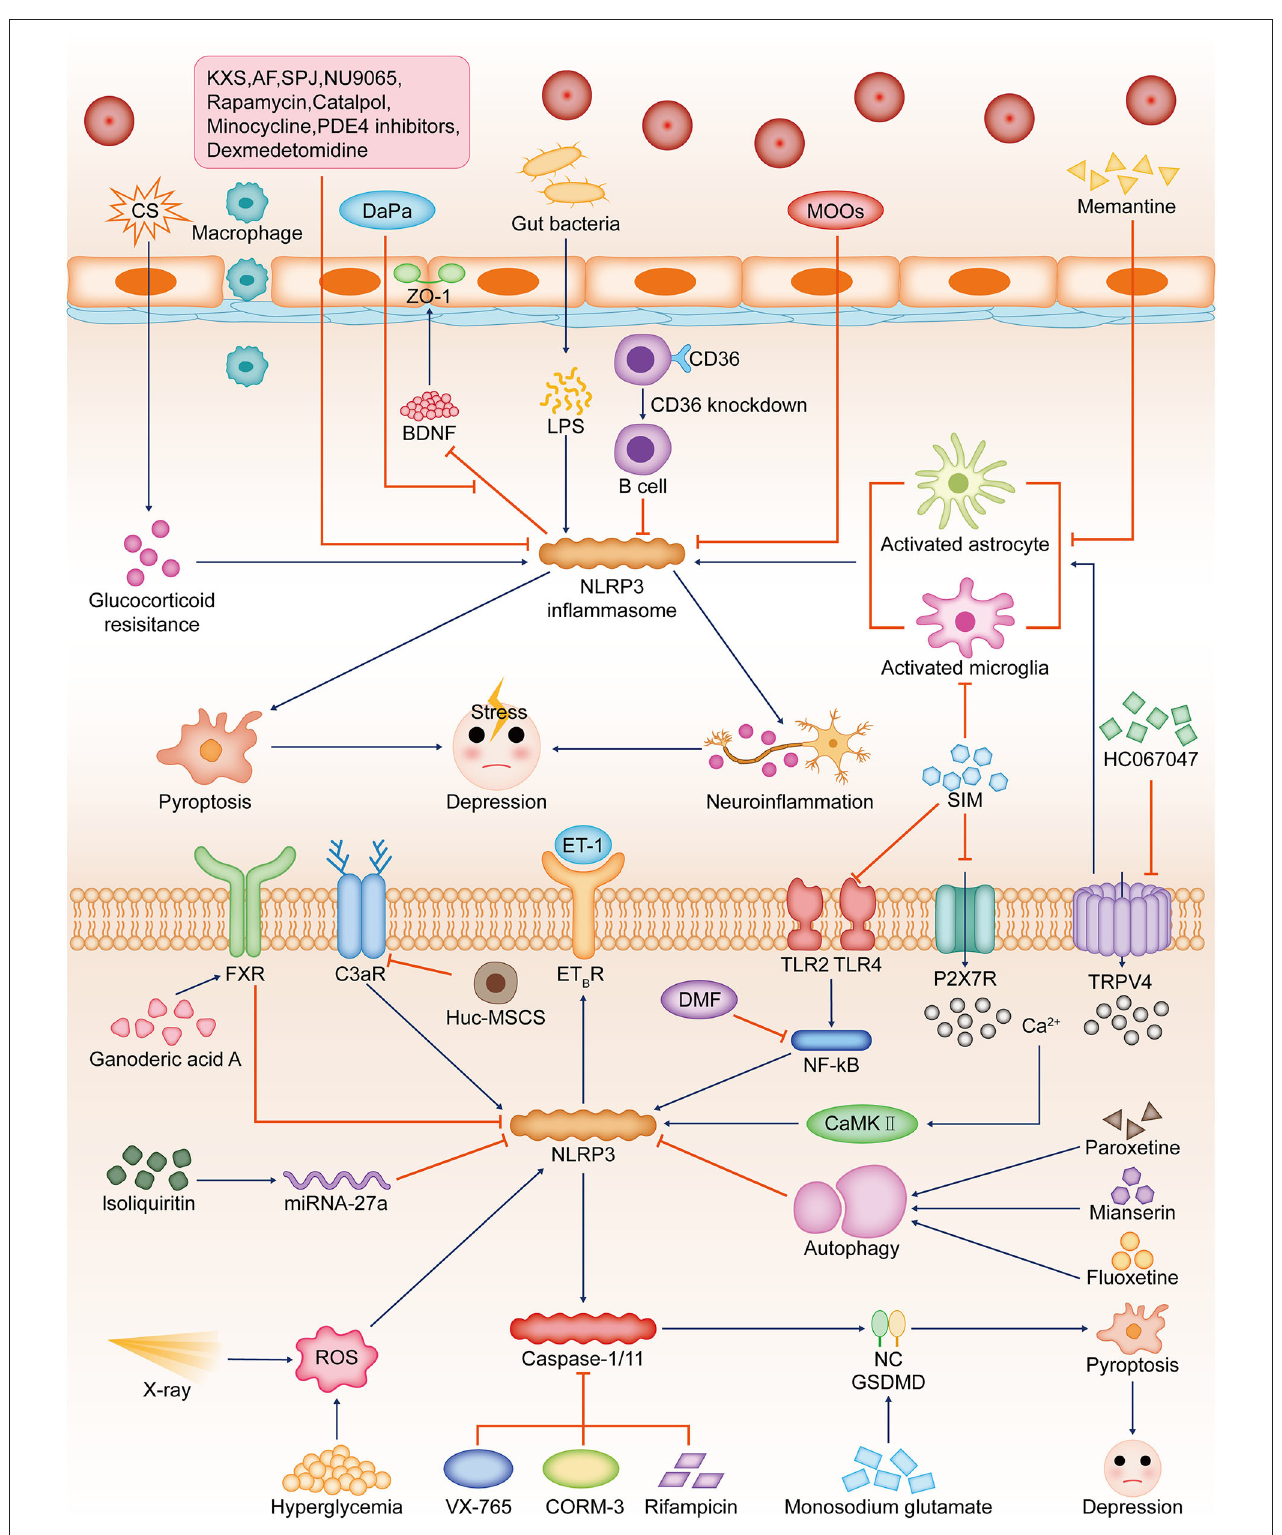
FIGURE 3 | Relationship between NLRP3-dependent pyroptosis and depression. In different models of stress-induced depression, NLRP3 inflammasome activation can worsen depression-like behaviour by inducing pyroptosis and triggering neuroinflammation. Hyperglycemia and X-ray can induce ROS production, which leads